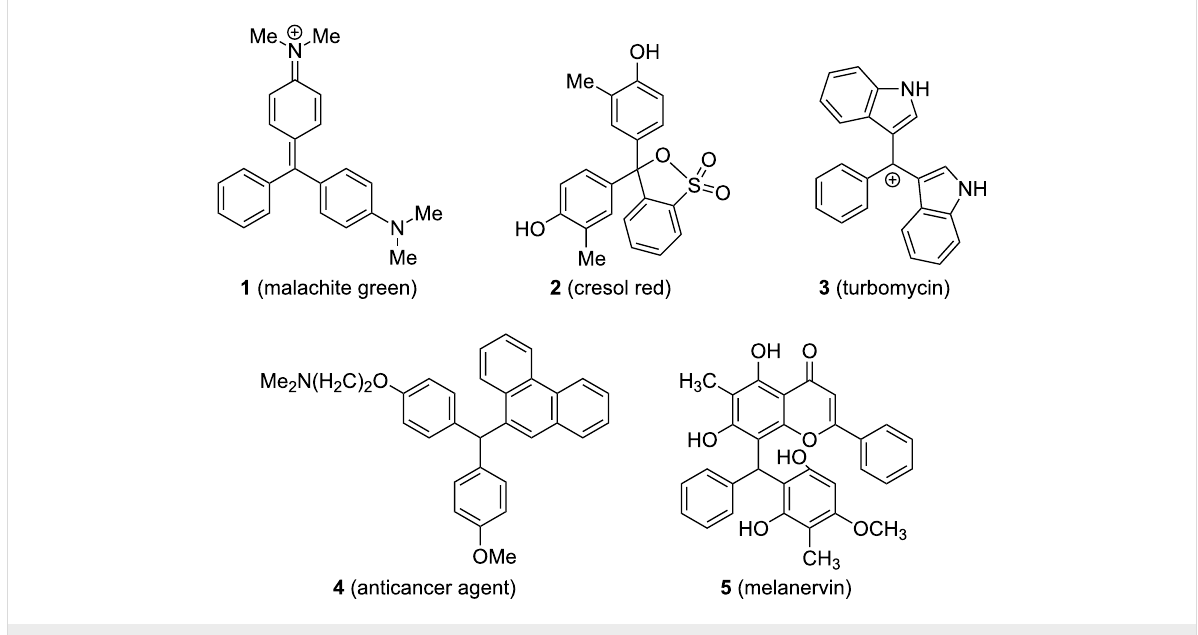
Figure 1: Representative examples of triarylmethanes.